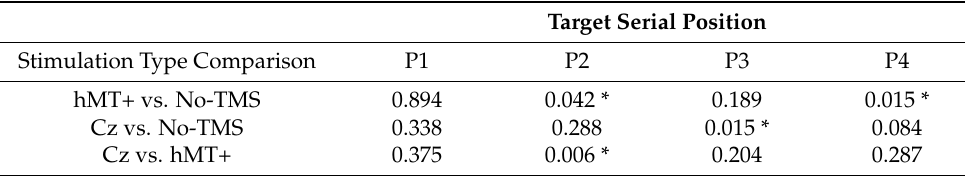
Table 1. Selected post hoc comparisons between precision values for the different stimulation types and for each target position. Significant p values are indicated with an asterisk. Target Serial Position Stimulation Type